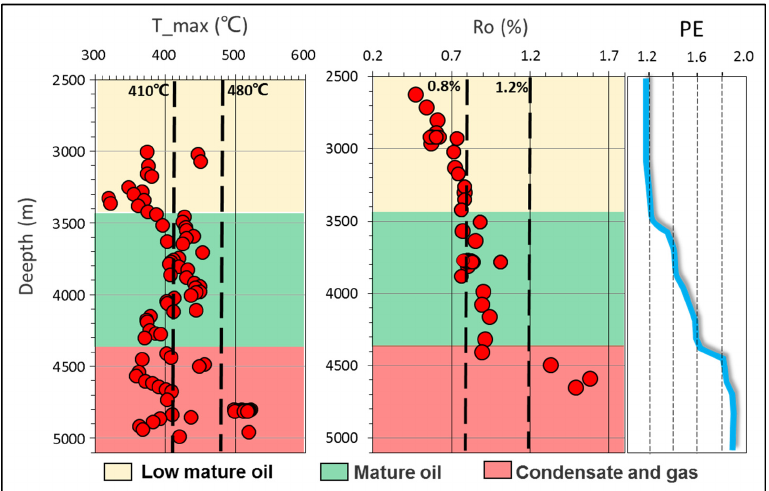
Figure 10. The measured temperature and Ro data vs. depth in the Pinghu